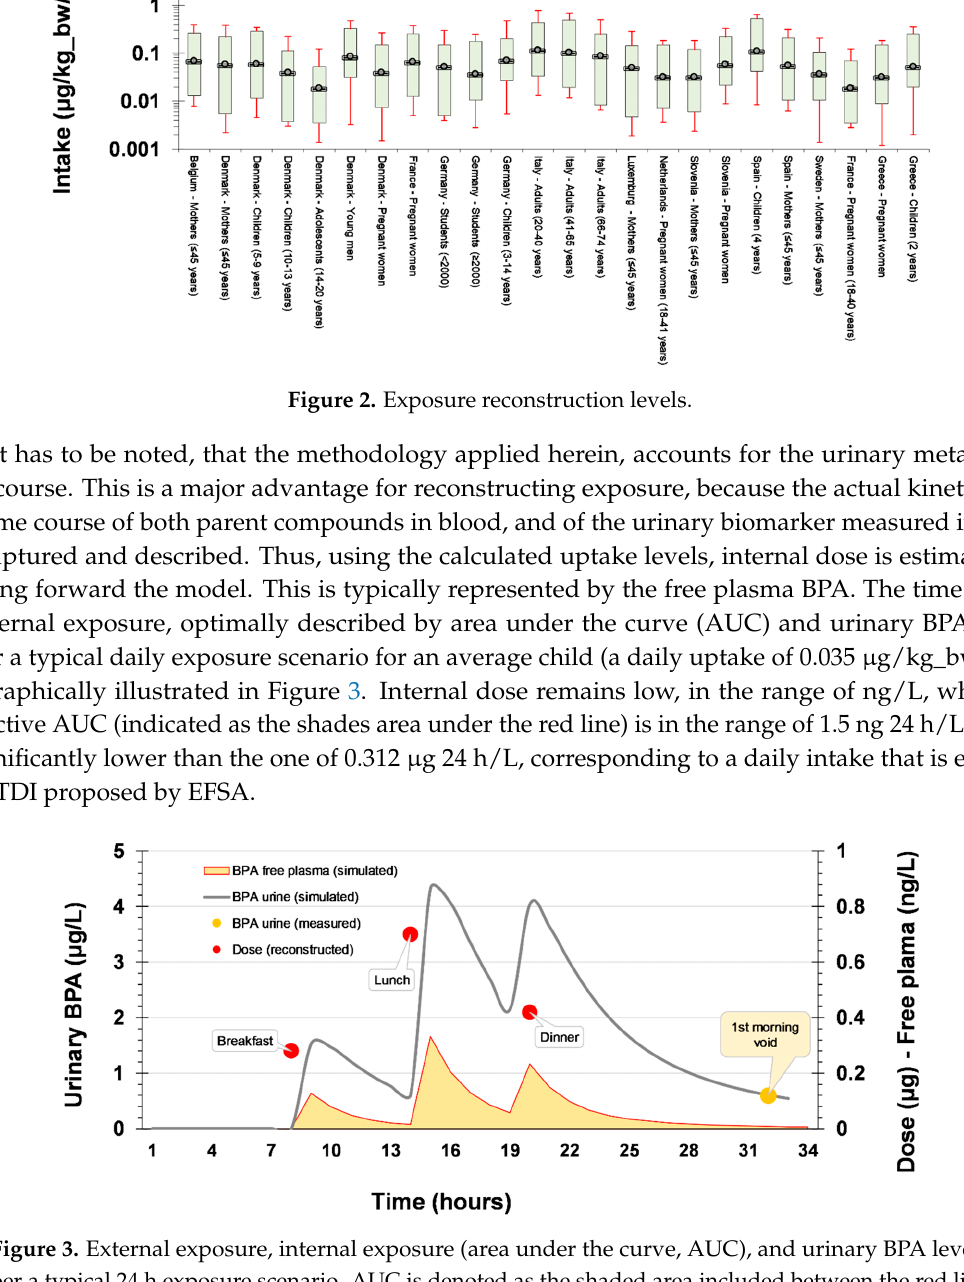
Figure 3. External exposure, internal exposure (area under the curve, AUC), and urinary BPA levels per a typical 24 h exposure scenario. AUC is denoted as the shaded area included between the red line and the x-axis.